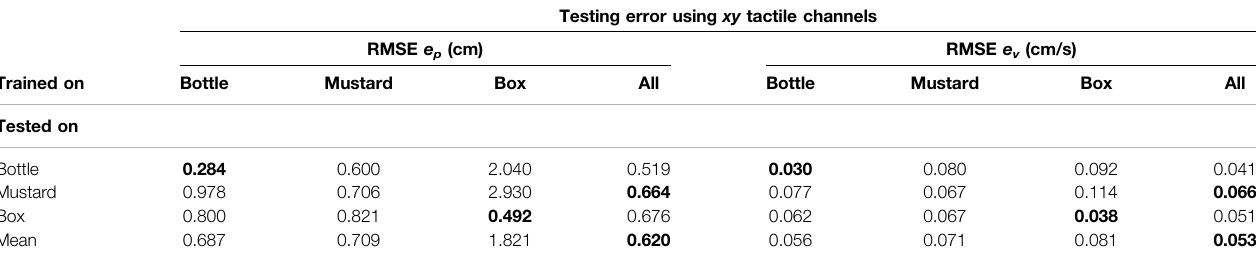
TABLE 4 | Position and velocity RMS testing errors using different combinations of training and testing sets. The model name “ all ” indicates a training set consisting in the union of the training sets of all the